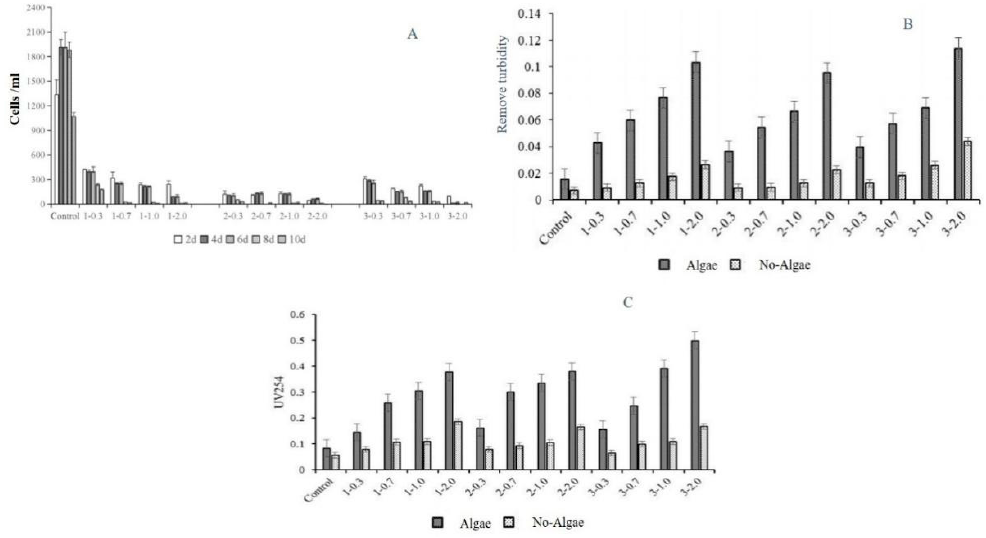
Figure 4. ( A ) Effect of fermentation broth on the growth of G. catenatum; ( B ) effect of algal removal from fermentation broth on turbidity; ( C ) effect of algal removal from fermentation broth on UV 254